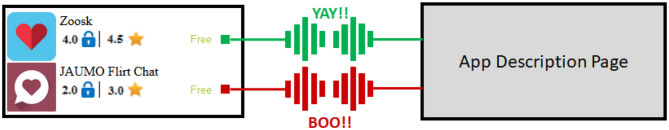
Sounds associated with apps. Choosing an app with a high privacy rating results in cheers and choosing an app with a low privacy rating results in jeers.